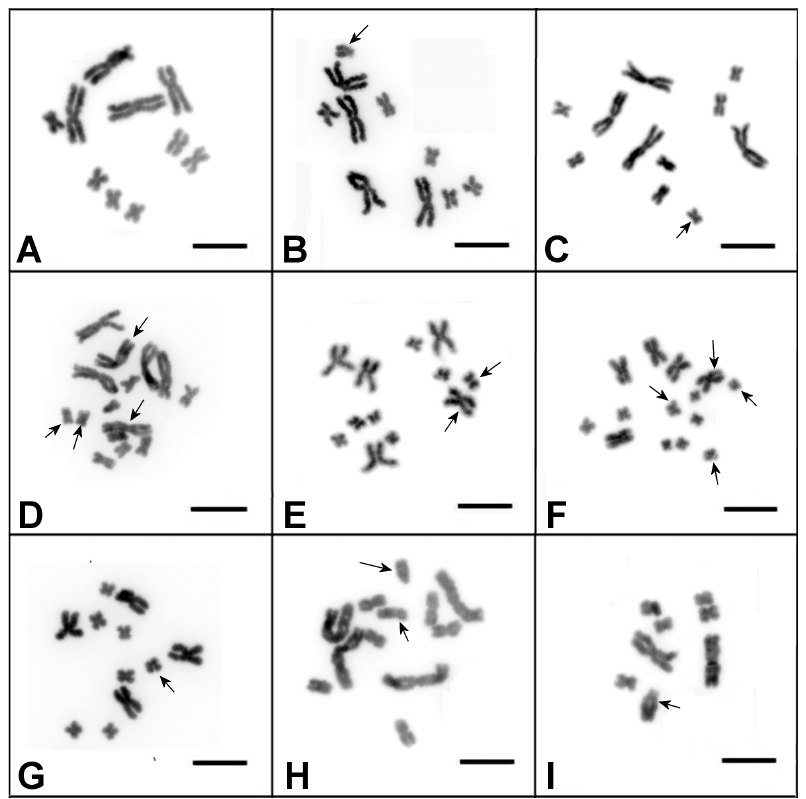
Figure 2. Metaphase plates from the worms of the DV1/10 inbred subline with the “normal” karyotype (2n = 10; four large and six small metacentrics) ( A ) and with abnormal karyotypes ( B – I ). ( B ) 2n = 10; four large, five small metacentrics, one small acrocentric chromosome (indicated by the arrow); ( C ) 2n = 11; four large and seven small metacentrics (additional small chromosomes indicated by the arrow); ( D ) 2n = 15; four large and nine small metacentrics (additional chromosomes indicated by the arrow); ( E ) 2n = 12; five large and seven small metacentrics (additional chromosomes indicated by the arrow); ( F ) 2n = 14; five large and nine small metacentrics (additional chromosomes indicated by the arrow); ( G ) 2n = 11; four large and seven small metacentrics (additional metacentric indicated by the arrow); ( H ) 2n = 12; four large and seven small metacentrics and one small acrocentric chromosome (additional metacentric and acrocentric indicated by the arrow); ( I ) “abnormal” 2n = 8; two large metacentrics, one medium-sized acrocentric chromosome (acrocentric indicated by the arrow) and five small metacentrics. Chromosomes were stained with DAPI (4',6-diamidino-2-phenylindole) (inverted images are shown). Scale bar: 10 µm.